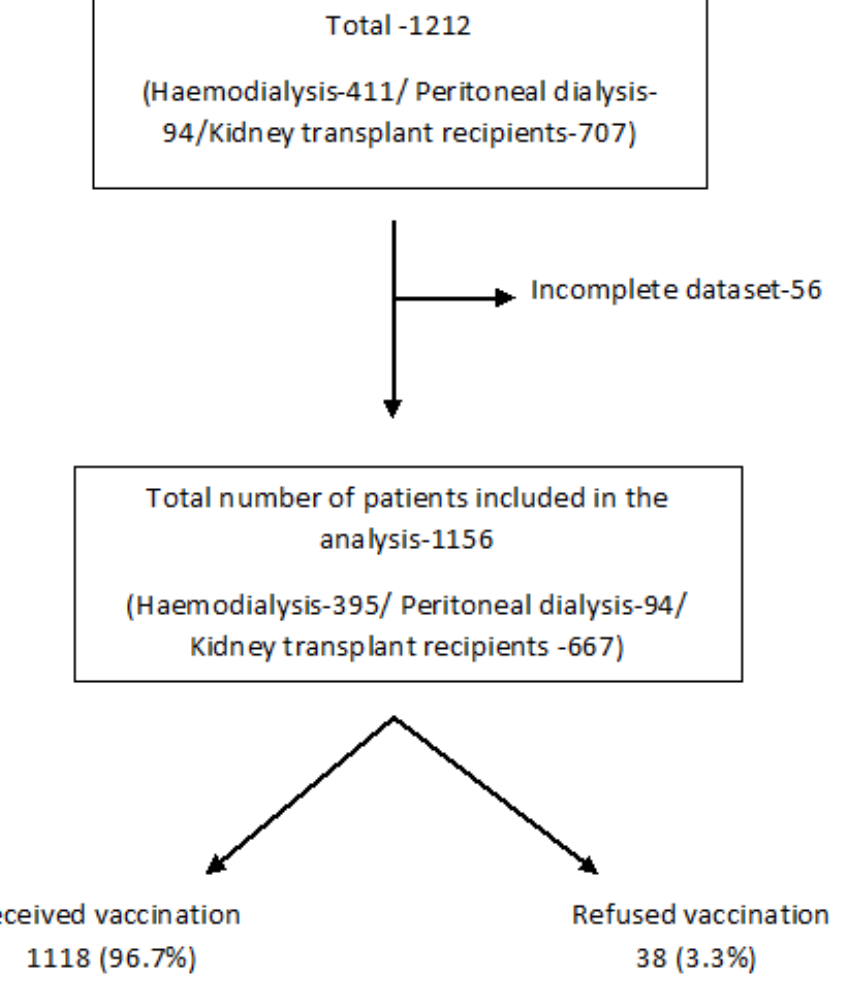
Figure 1. A flowchart of patients.